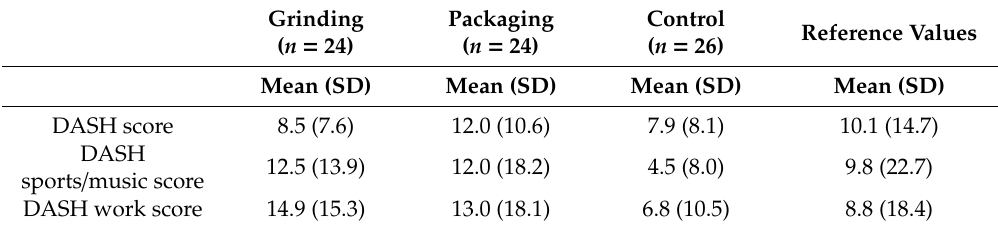
Table 3. Demographic data: continuous parameters.